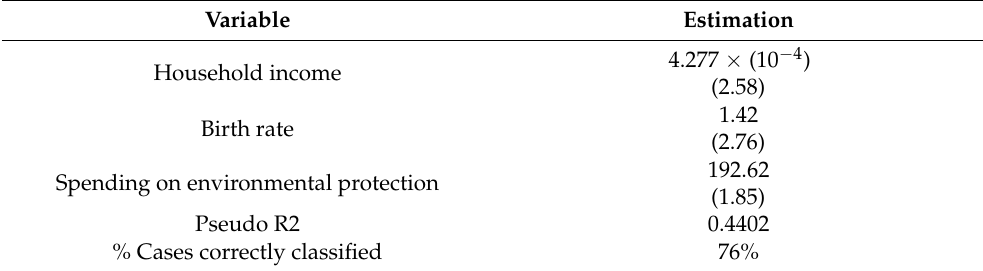
Table 4. Estimation of the ordered logit